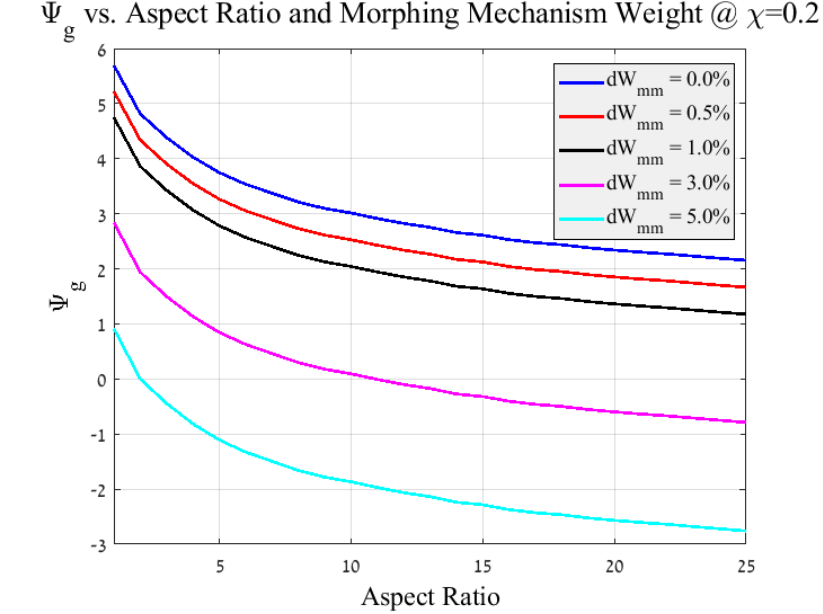
Figure 11. Ψ g vs. aspect ratio and several morphing mechanism weight at flight scenario χ =